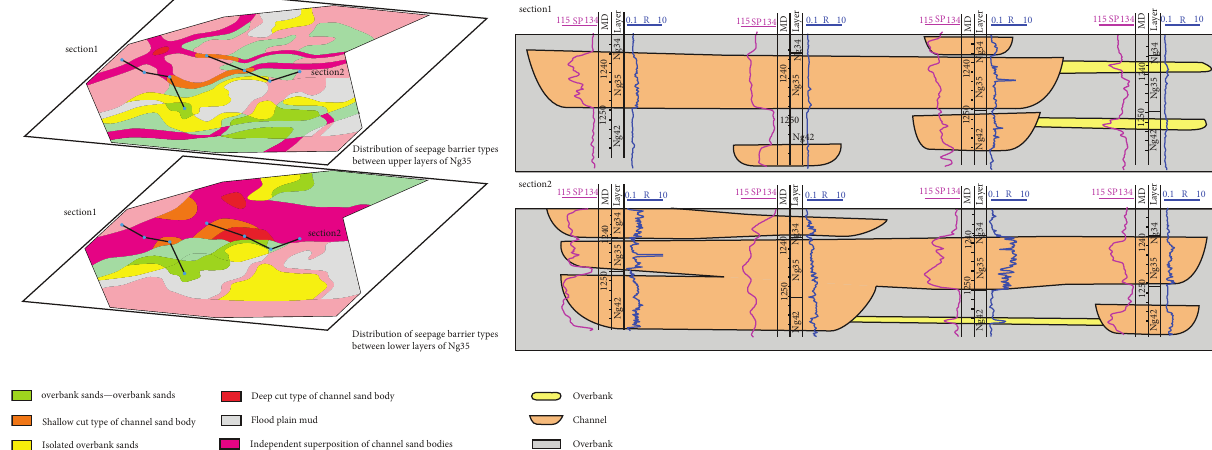
Figure 6: Distribution characteristics of interlayer seepage barriers.